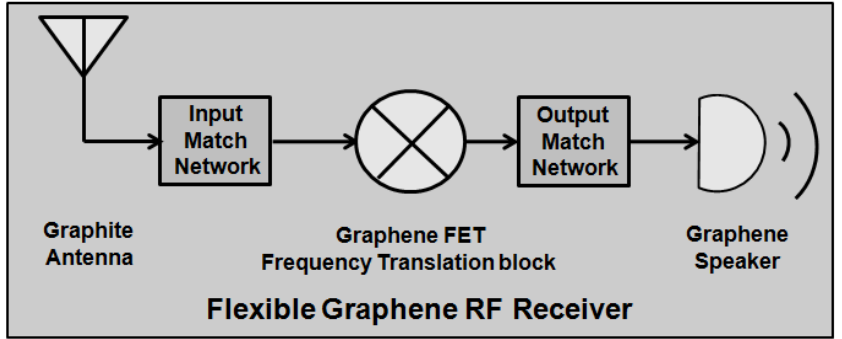
Figure 5. Schematic of a Flexible graphene based RF